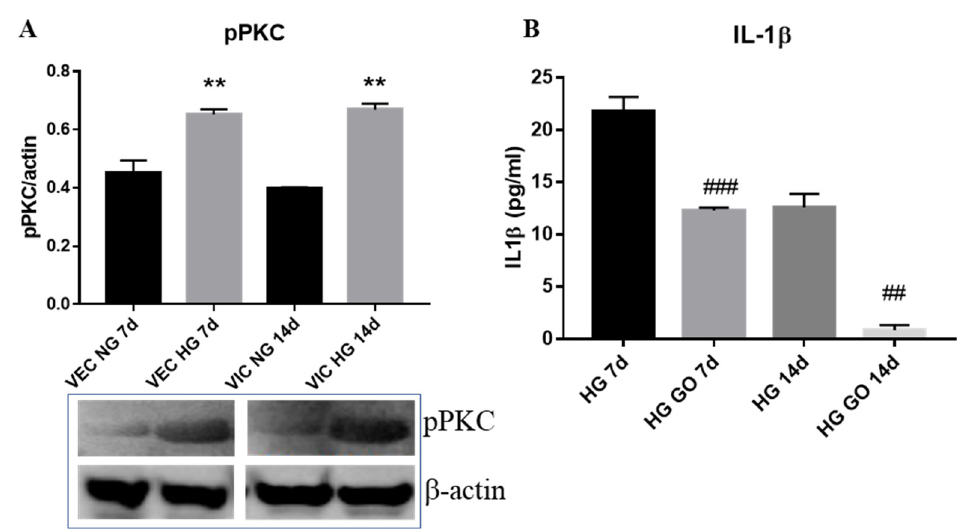
Figure 7. ( A ) Expression of phosphorylated forms of PKC in VEC and VIC isolated from 3D model of aortic valve. Western blot was realized on cell lysate from valvular cells isolated from 3D construct after 7 and 14 days of glucose exposure. Compared to NG (black columns), cells from HG (grey columns) exhibit increased expression of pPKC- α . N = 3, ** p < 0.01. ( B ) Quantification of protein levels of IL-1 β released by valvular cells from the 3D model exposed to HG level in the presence or absence of PKC inhibitor, GO 6983; ## p < 0.01, ### p < 0.001.